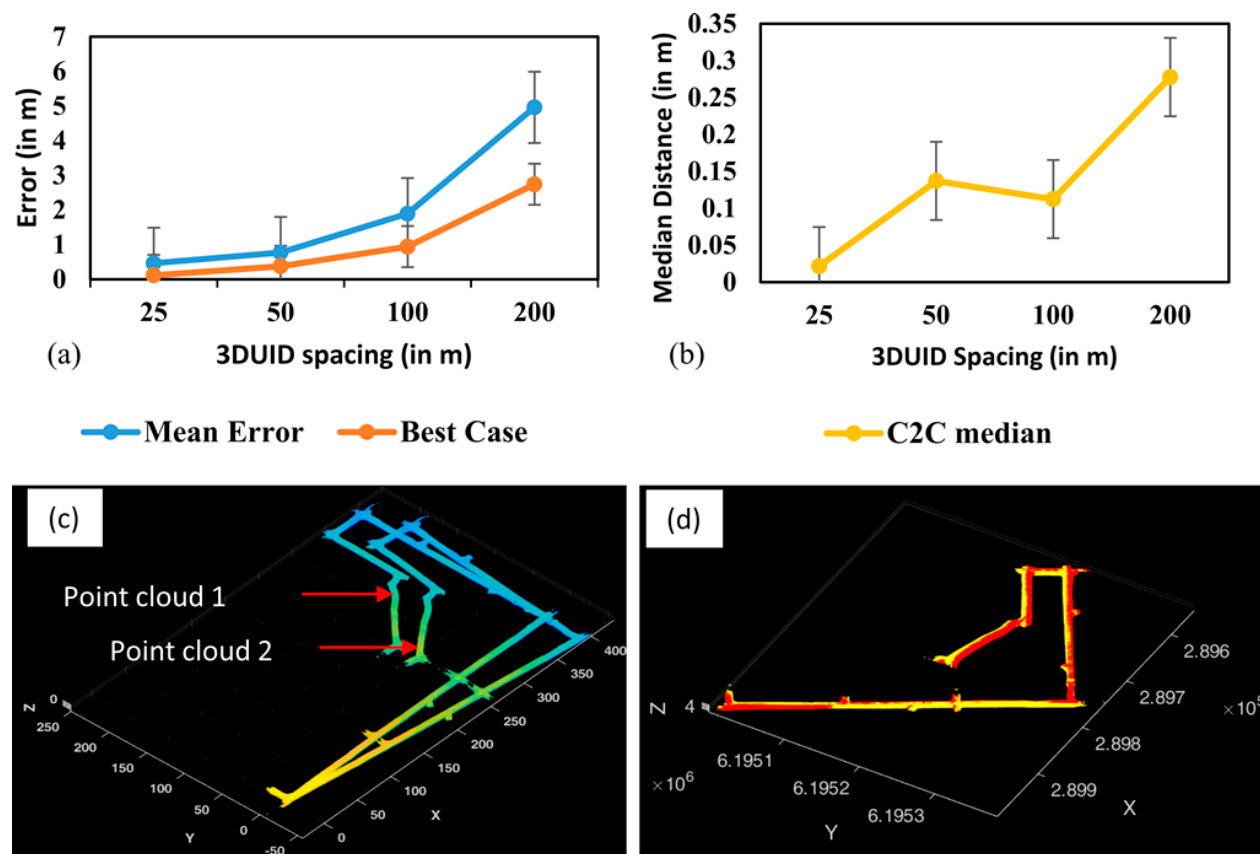
Figure 8. ( a ) Error between georeferenced coordinate and corresponding surveyed coordinate through LOOCV error analysis for different 3DUID spacing, ( b ) a cloud-to-cloud distance comparison between two georeferenced point clouds achieved using 3DUID tags with varying spacing, ( c ) the two point clouds in local coordinate system achieved after SLAM processing, and ( d ) georeferenced/globally aligned point cloud. Table 1. Mean absolute error in georeferencing for sections with different 3DUID spacing levels. 3DUID Spacing (in m)